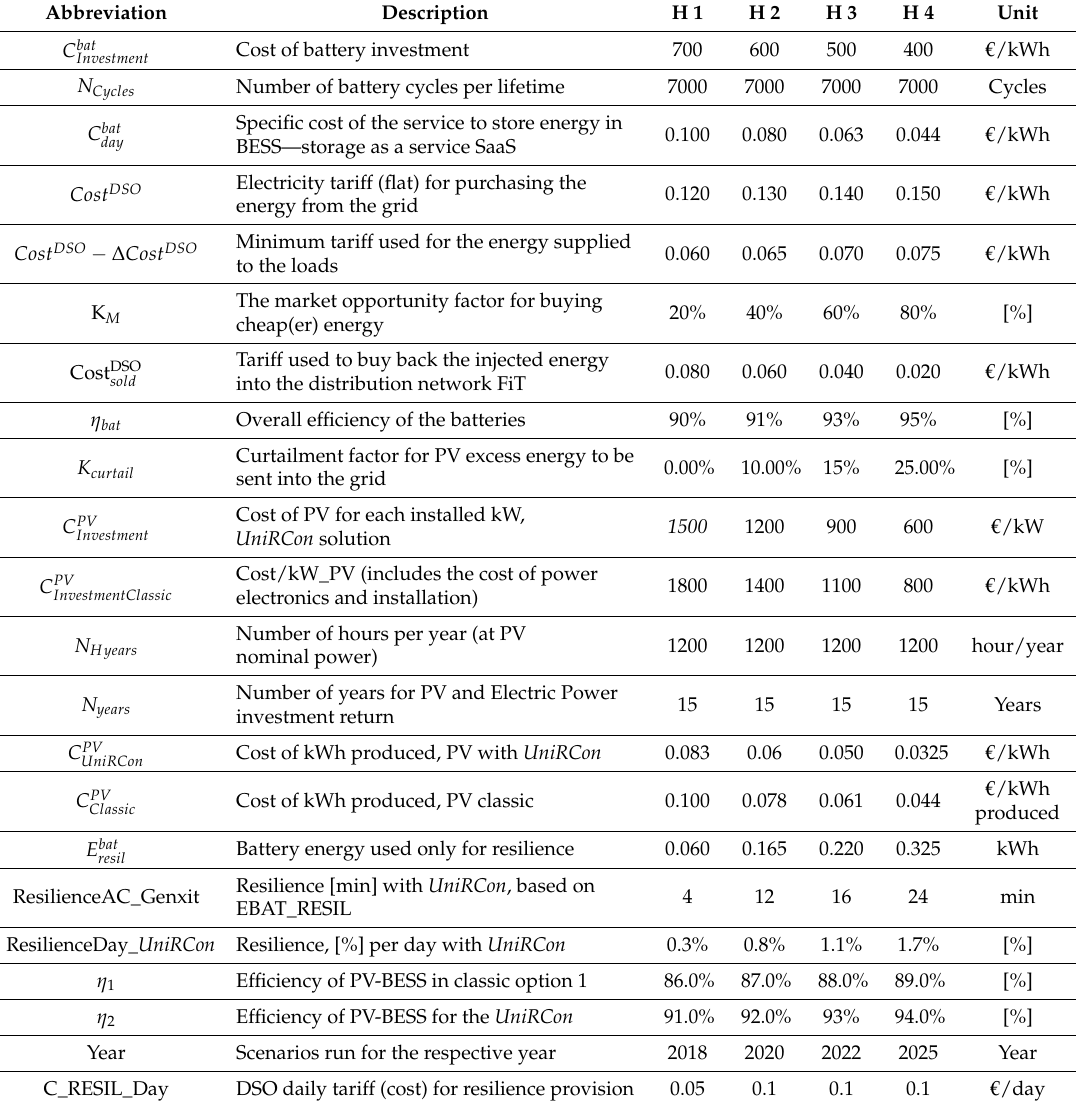
Table 4. Technical and economic input